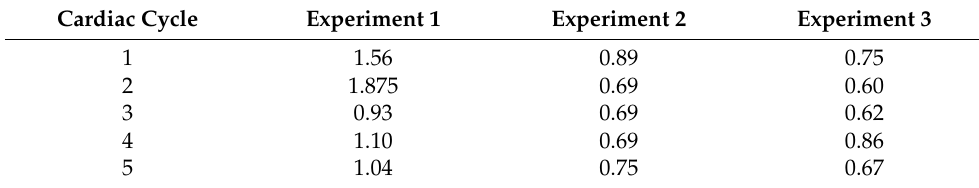
Table 13. Experimental PRT measured in second (s) for each cardiac cycle for patient 2. Cardiac